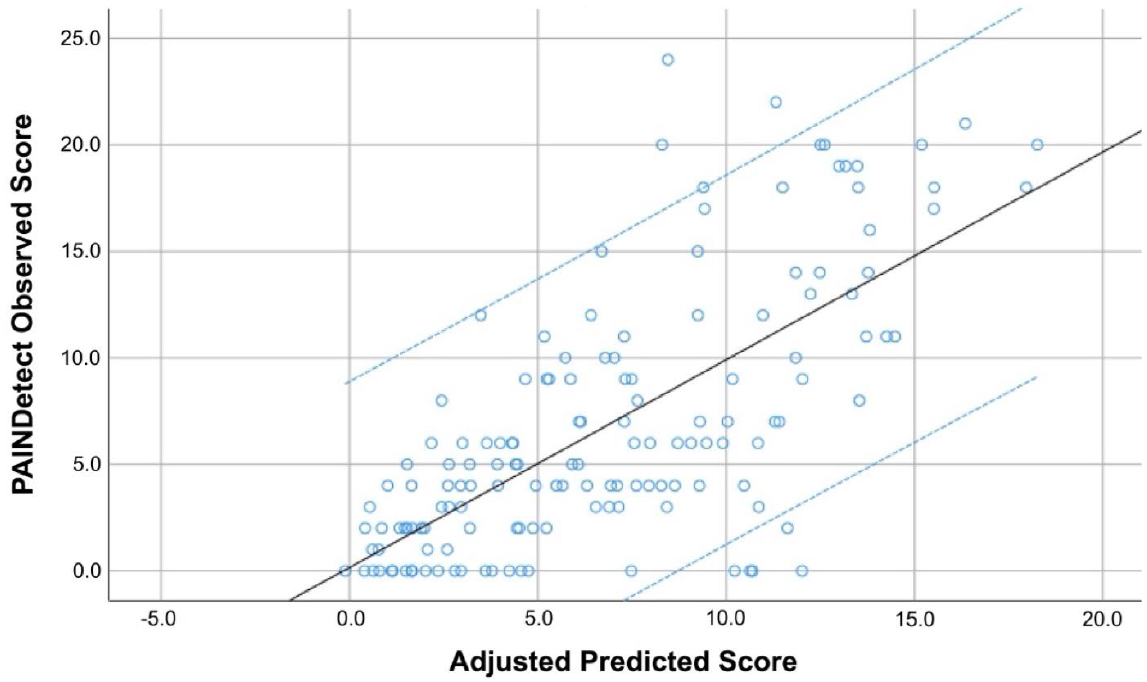
Figure 2. Scatter plot of the adjusted predicted score (r 2 adjusted: 0.512) explaining the PainDETECT score in COVID-19 survivors with post-COVID pain symptoms ( n = 146). Note that some points can be overlapping. Black line represents de mean predicted score whereas the blue lines represent the 95% confidence intervals.